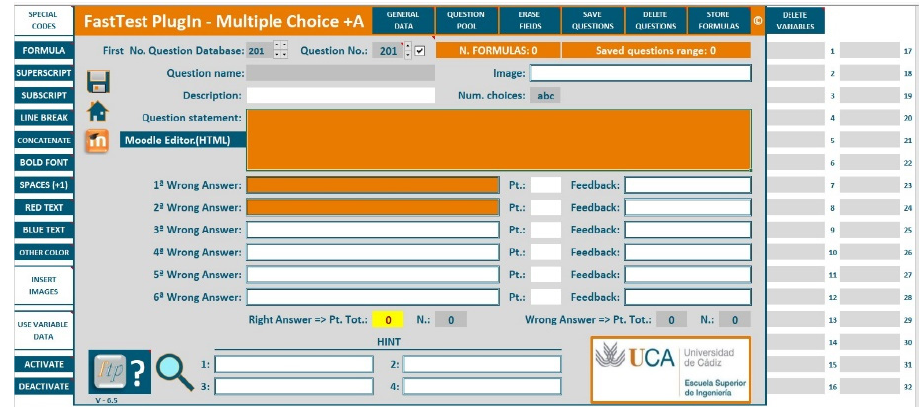
Figure 2. General question data entry interface (the example shows a form for a MCQ with one